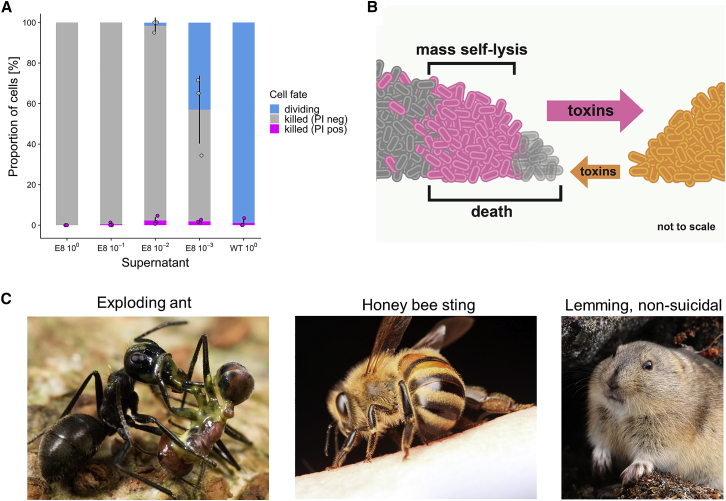
Suicidal Behavior Is Associated with Low Reproductive Potential(A) Cell-fate frequencies in response to colicin E8 in E. coli cells unable to self-lyse. WT pUA66-PcolE2::gfp cells were exposed to different dilutions of supernatant of a colicin E8-producing strain or a non-producing wild-type. Cells were imaged for up to 6 h, and the fate of n = 3,666 cells across all treatments was categorized as either dividing, dead and PI-negative, or dead and PI-positive. Error bars indicate SEM across three or four biological replicates. A Kruskal-Wallis test did not yield a statistically significant relationship between supernatant concentrations and frequency of cells positive for PI-specific fluorescence (chi-square test = 7.8486, df = 4, p = 0.09).(B) Illustration of the mass cell suicide phenotype. In the region where the toxins (orange arrow) of the competing strain (orange) reaches lethal levels, large number of cells of the focal strain lyse (pink) and release colicins en masse (pink arrow). Cell suicide does not occur at the very edge of the colony on the left (transparent gray cells), as these cells die immediately from the competitors toxins.(C) Two examples of suicidal behaviors in social insects, and a popular misconception. Left: a minor Colobopsis cylindricus (“exploding ant”) worker has ruptured her body to release a sticky yellow substance, killing both herself and her opponent, the larger worker of another ant species (Camponotus sp.) [7, 34]. Middle: honeybee (Apis mellifera) workers sting in defense of their colony, which often results in the worker’s death as the sting gets pulled out of her body [8]. Right: a long-standing myth incorrectly holds that lemmings commit mass suicide. The example is illustrative because—unlike in the social insects and bacteria where low reproductive potential and benefits to kin can explain suicidal behaviors—there is no evolutionary rationale for such behavior in lemmings. Image sources: ants (Mark Moffett/Minden Pictures, used with permission); honeybee (Alexander Wild, used with permission); northern collared lemming (Jeremy Gatten, used with permission).